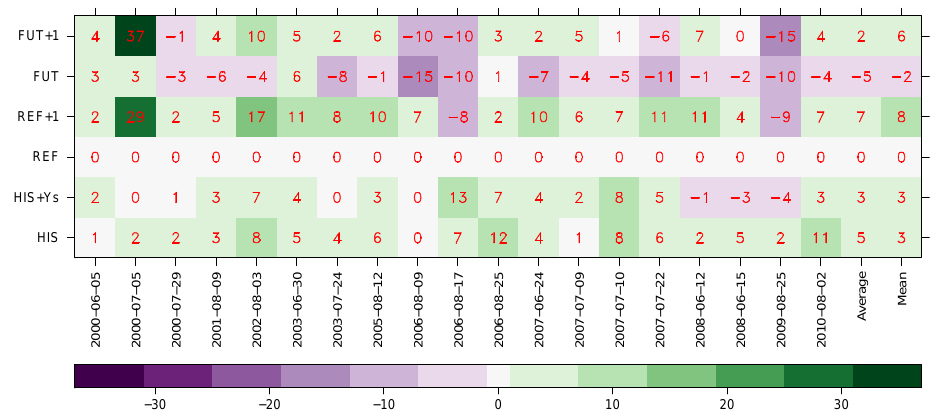
Figure 6. Relative precipitation difference (%) in each of the cases for all experiments compared to REF. Here the average is directly calculated over the 18 selected cases and the mean is calculated using the mean spatial differences as given in Fig. 7.